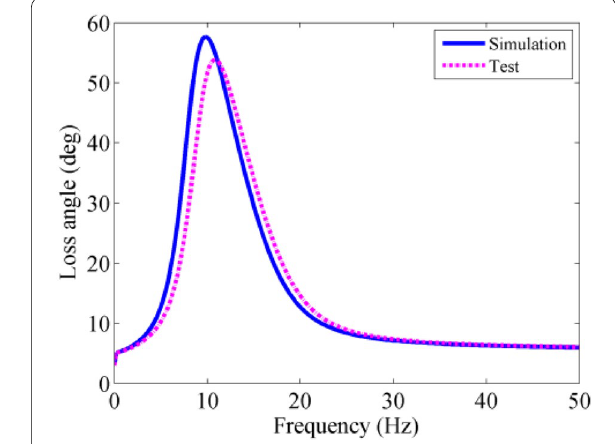
Figure 9 Loss angle vs. frequency curves